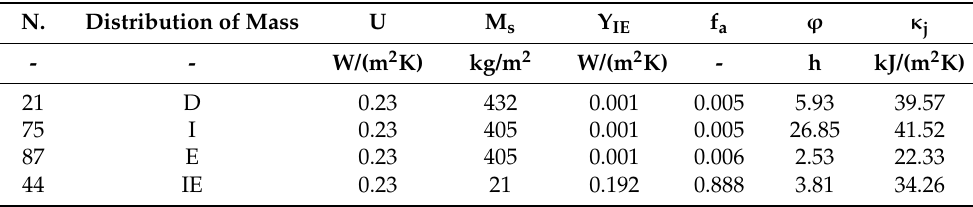
Figure 8. Indication of the points on which the surface temperatures of the living room are calculated. Table 8. Selected structures, among those analyzed, with similar transmittance but different surface mass and mass distribution.